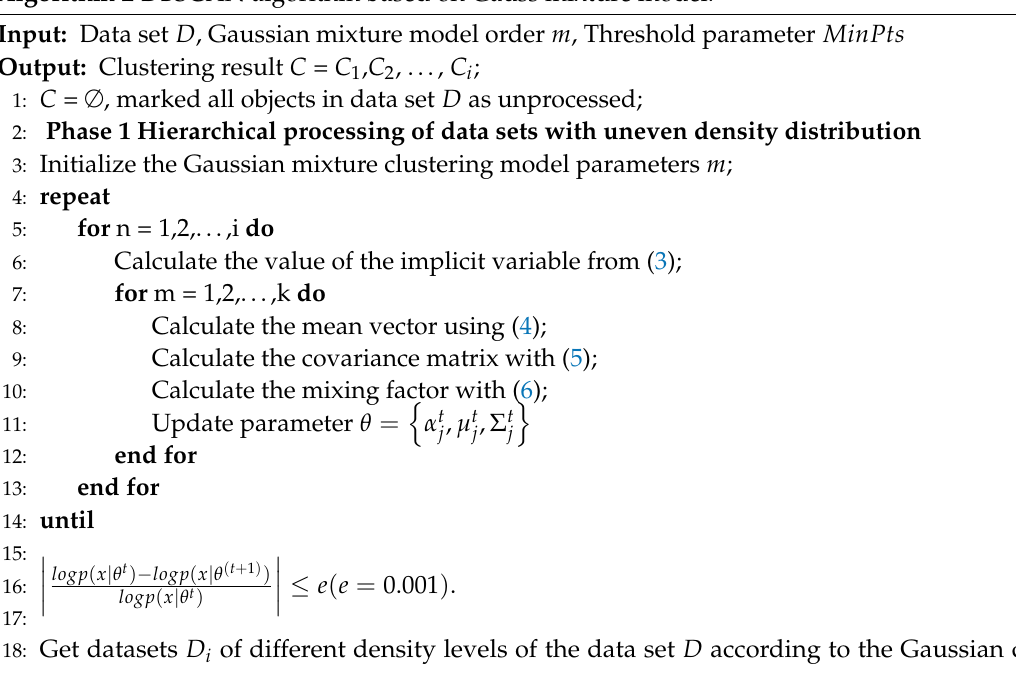
Algorithm 2 DBSCAN algorithm based on Gauss mixture